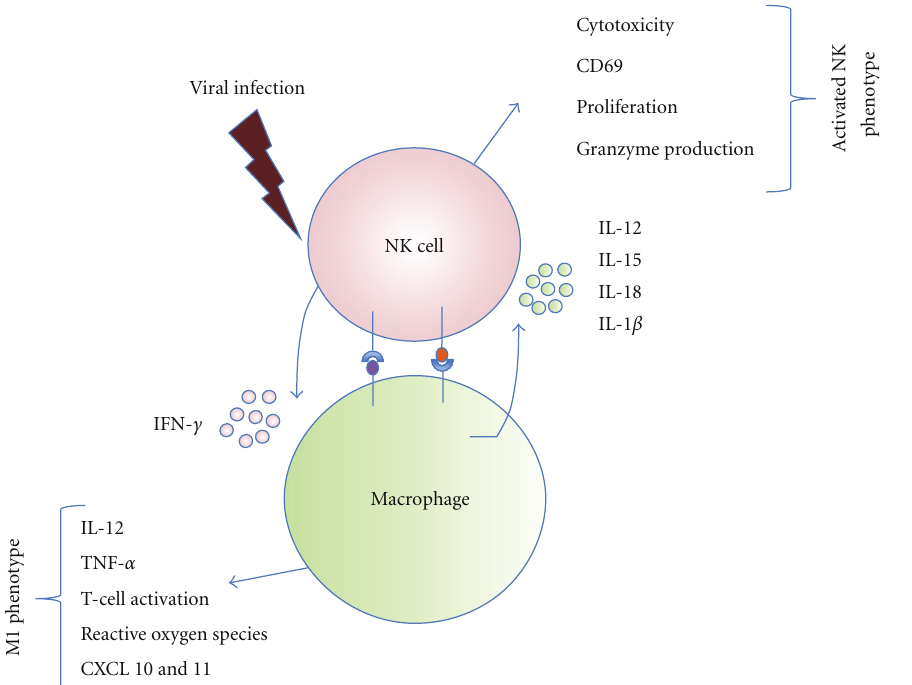
Figure 3: Innate immune e ff ector cells, including NK cells and macrophages, represent an initial barrier to viral infection, replication, and spread. Following infection, NK cells are recruited to the site of infection and adopt an activated phenotype. Through their IFN- γ production, they also facilitate the maturation and activation of macrophages which adopt an inflammatory “M1” phenotype. Lastly, macrophages create a feedback loop by producing a variety of inflammatory cytokines that mediate NK activation. This inflammatory response creates a potent antiviral microenvironment while also communicating with the adaptive